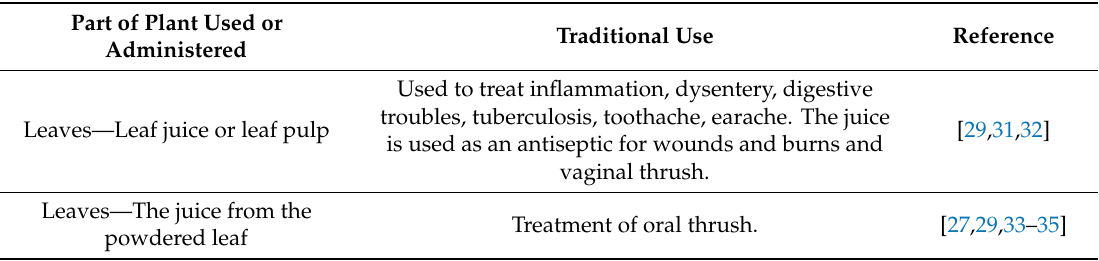
Table 1. Ethnomedicinal uses of Carpobrotus edulis